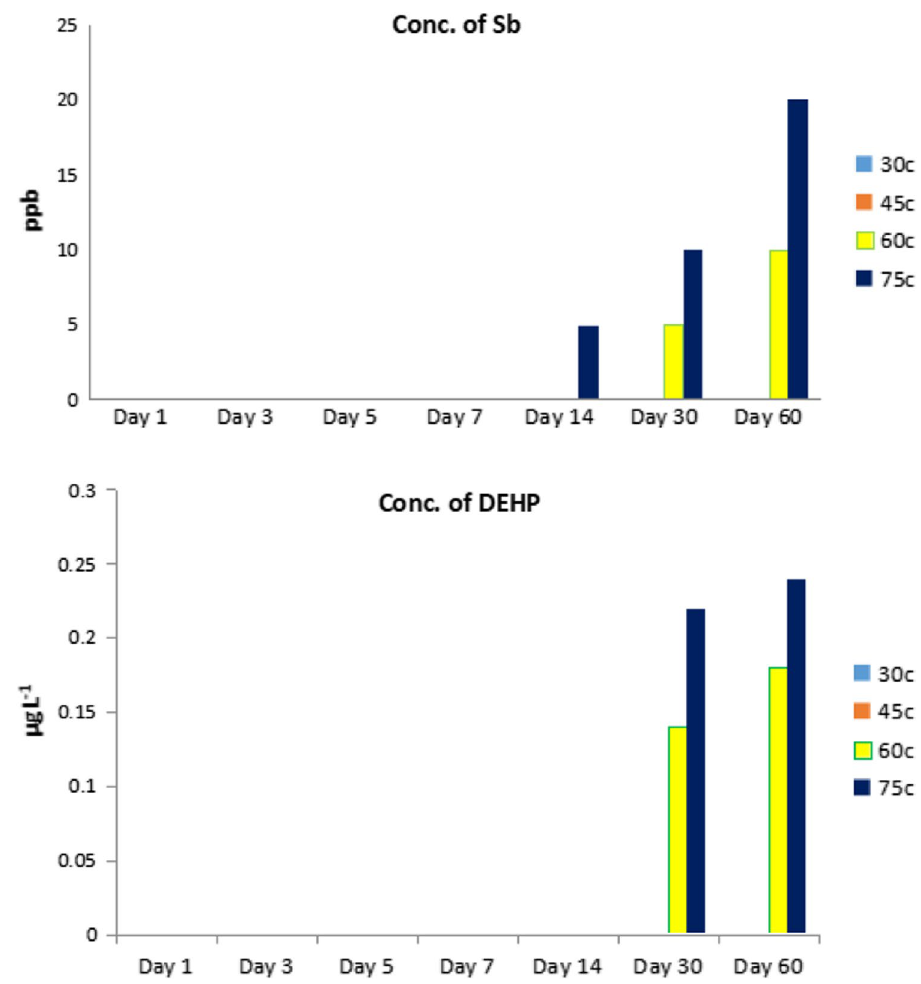
Fig. 1 Concentration of anti- mony in water from PET bottles